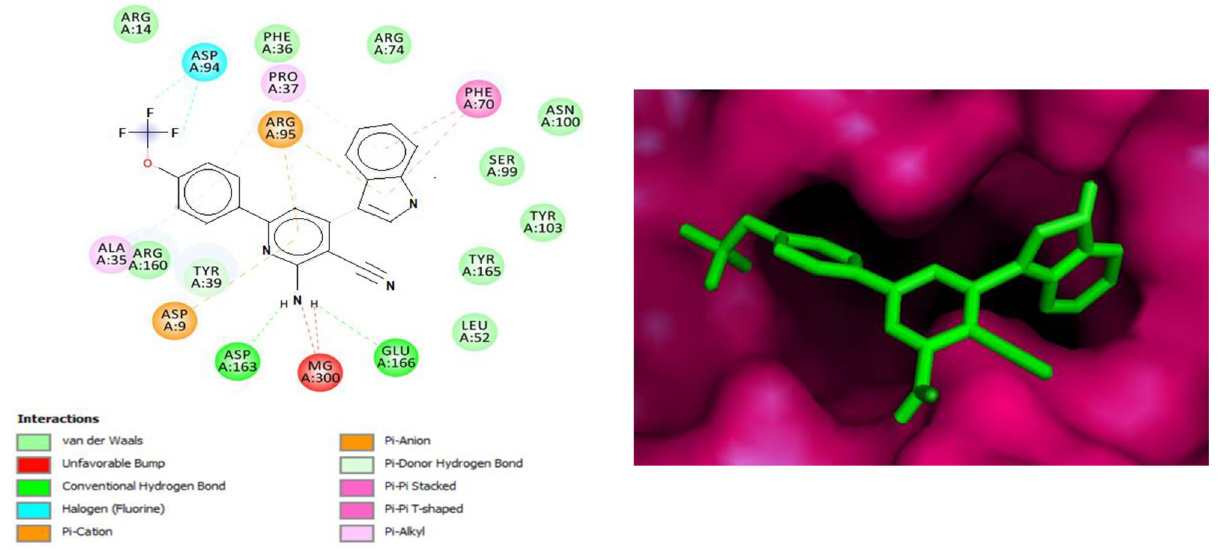
Fig 6. 2D and 3D interactions of 40 with PZA active site of 1G3U, which shown hydrogen bond and other interactions. 6 of pyridine motif with ASP94 had further substantiated the binding and enhanced the activ-